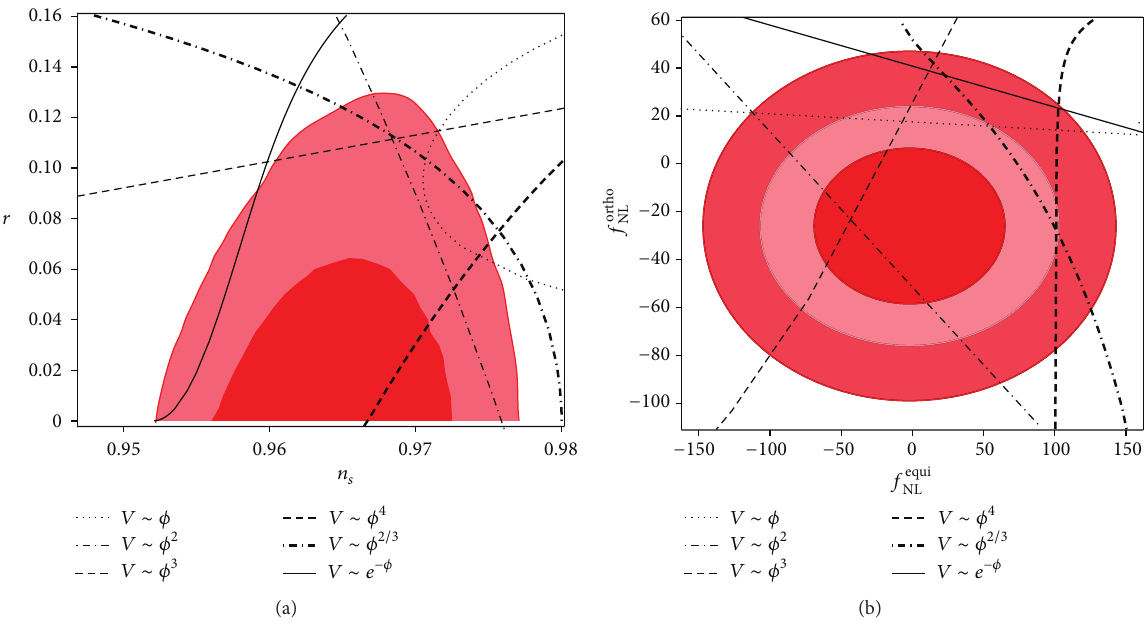
Figure 3: Tensor-to-scalar ratio versus the scalar spectral index for an inflationary model in which both inflaton and its derivative are nonminimally coupled to gravity, in the background of Planck 2015 TT, TE, and EE + lowP data (a) and the amplitude of the orthogonal configuration versus the equilateral configuration of non-Gaussianity for an inflationary model in which both inflaton and its derivative are nonminimallycoupledtogravity,inthebackgroundofPlanck2015TTT,EEE,TTE,andEETdata(b).Figureisplottedwith 𝑛 = 2 , 𝑓(𝜙) ∼ 𝜉𝜙 2 , and various types of potential, for 𝑁 = 60